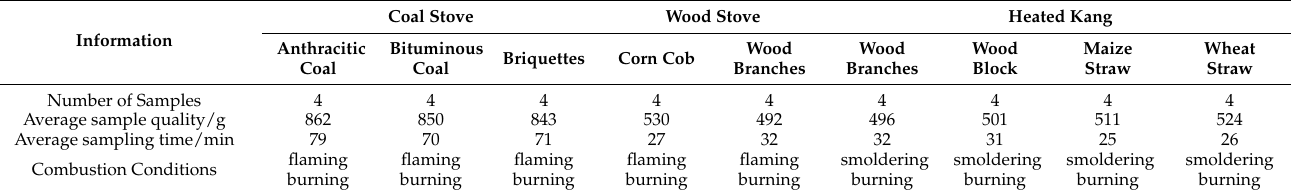
Table A1. Sampling information and combustion